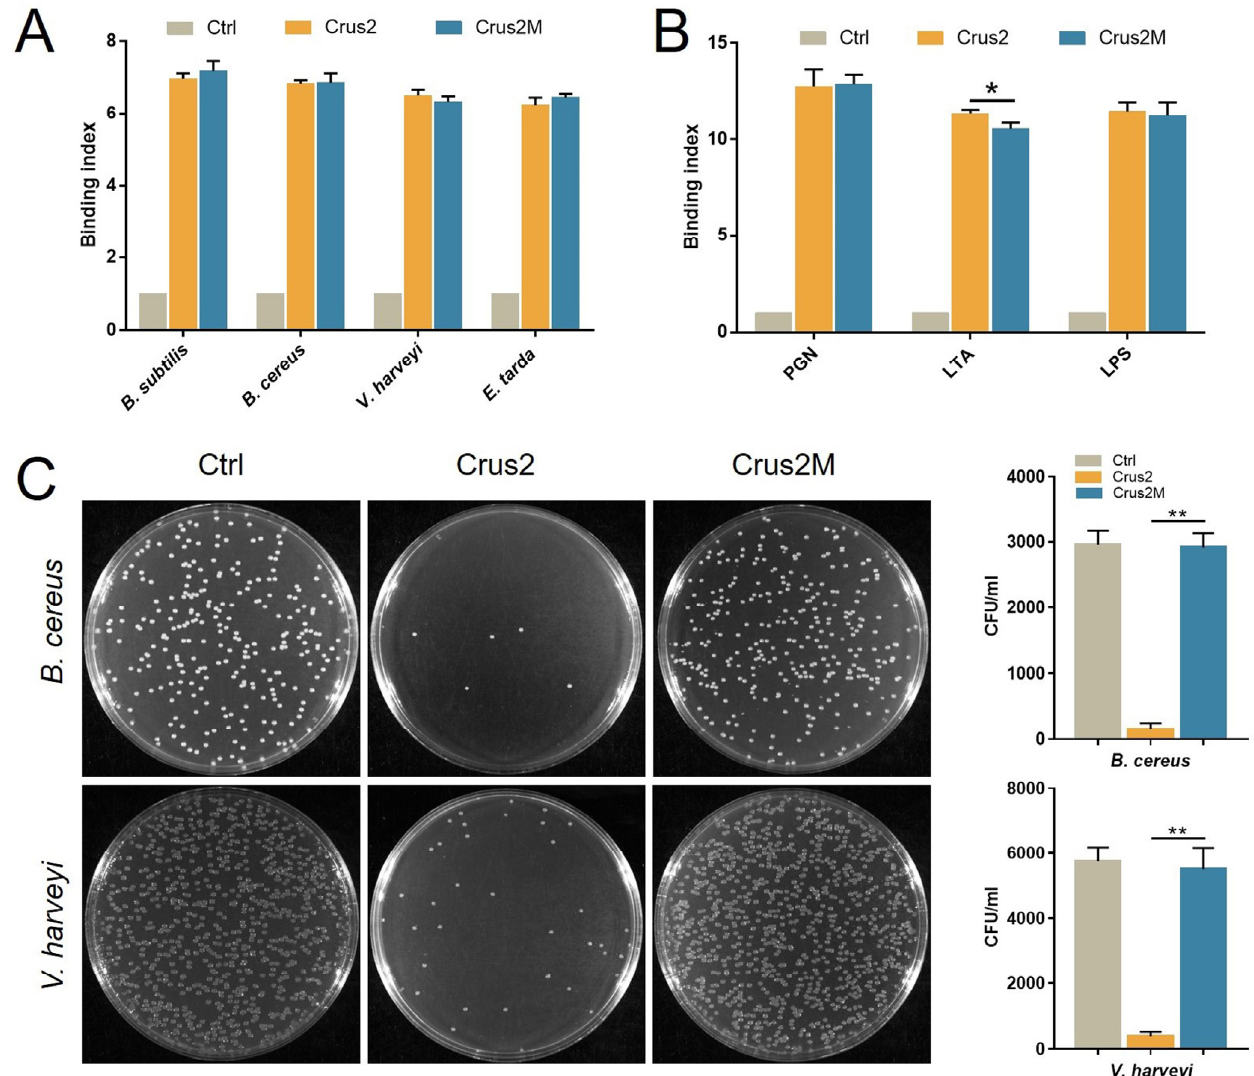
Figure 4. The bacterial binding and bactericidal activities of Crus2M. ( A ) Bacillus subtilis , Bacillus cereus , Vibrio harveyi and Edwardsiella tarda were incubated with or without (Ctrl) Crus2 or Crus2M. The binding was subsequently detected by ELISA. ( B ) Peptidoglycan (PGN), lipoteichoic acid (LTA), and lipopolysaccharide (LPS) were incubated with or without (Ctrl) Crus2 or Crus2M, and the binding was detected as above. ( C ) B. cereus and V. harveyi were treated with or without (Ctrl) 32 μ M Crus2 or Crus2M. After treatment, bacterial growth on MH agar plates was observed. The colony-forming units (CFU) on the plates are shown in the bar graphs. Data are the means triplicate experiments and shown as ±SD. ** and * represent p < 0.01 and p < 0.05, respectively (Student’s t test).